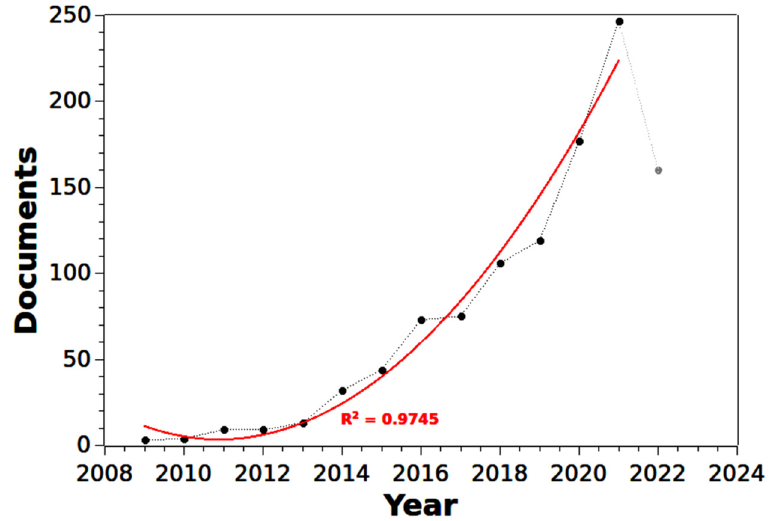
Figure 2. Documents per year (The model does not include 2022).